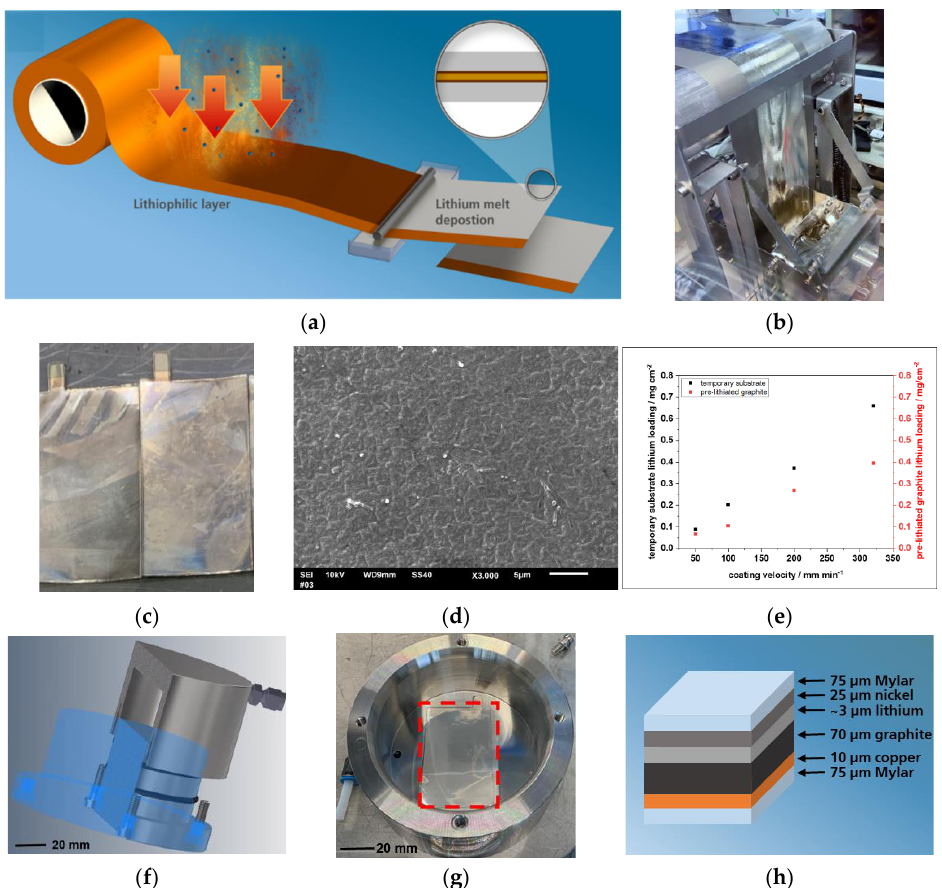
Figure 1. Schematic illustration of the lithium melt deposition process including substrate pre-treatment for lithiophilic interlayers and lithium deposition ( a ) [52]; photograph of the coating tool for continuous thin lithium film coating ( b ); photographs of lithium on nickel foil processed by different coating speeds (left:100 mm min − 1 , right: 150 mm min − 1 ) ( c ); SEM image of temporary substrate lithium surface ( d ); lithium loading on temporary substrate (black) and in pre-lithiated graphite electrodes (red) resulting from these temporary substrates determined electrochemically depending on the lithium coating velocity ( e ); CAD model of the pressing tool for electrolyte-free direct contact pre-lithiation ( f ); photograph of the opened pressing tool with inserted sample stack ( g ); sample stack consisting of temporary substrate and graphite electrode wrapped into polymer foil to avoid the sample sticking on the pressing tool ( h